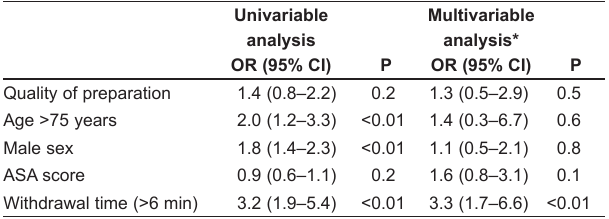
TAble 5 Independent predictors of inadequate bowel preparation in a screening setting